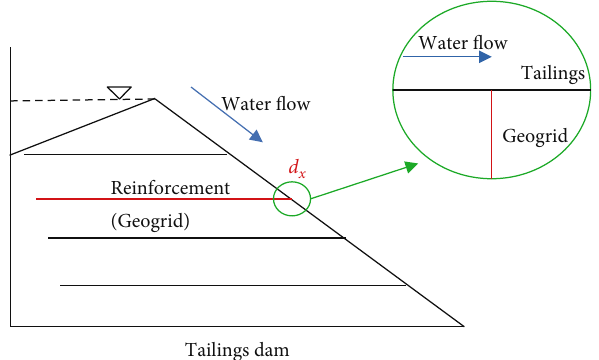
Figure 8: The layout of the reinforcements (i.e., geogrids) in the fi ne-grained tailing dam